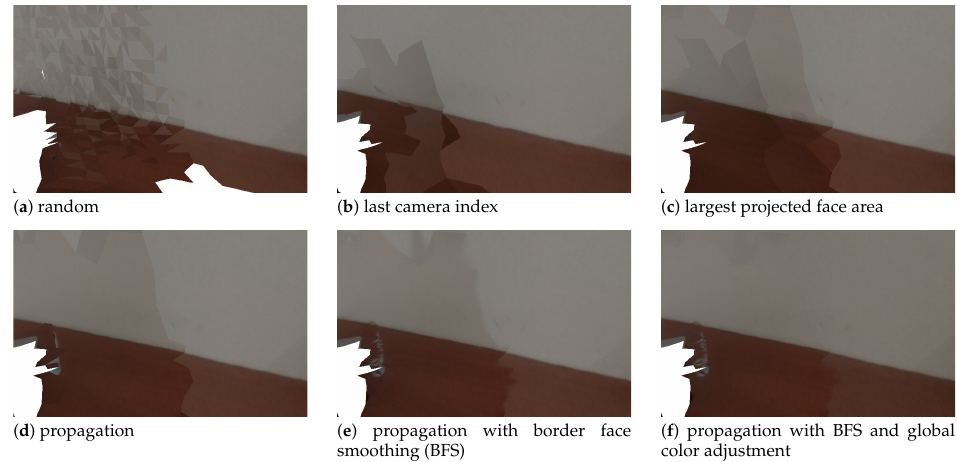
Figure 15. Zoom in of the area shown by the blue rectangle of Figure 14 for each respective